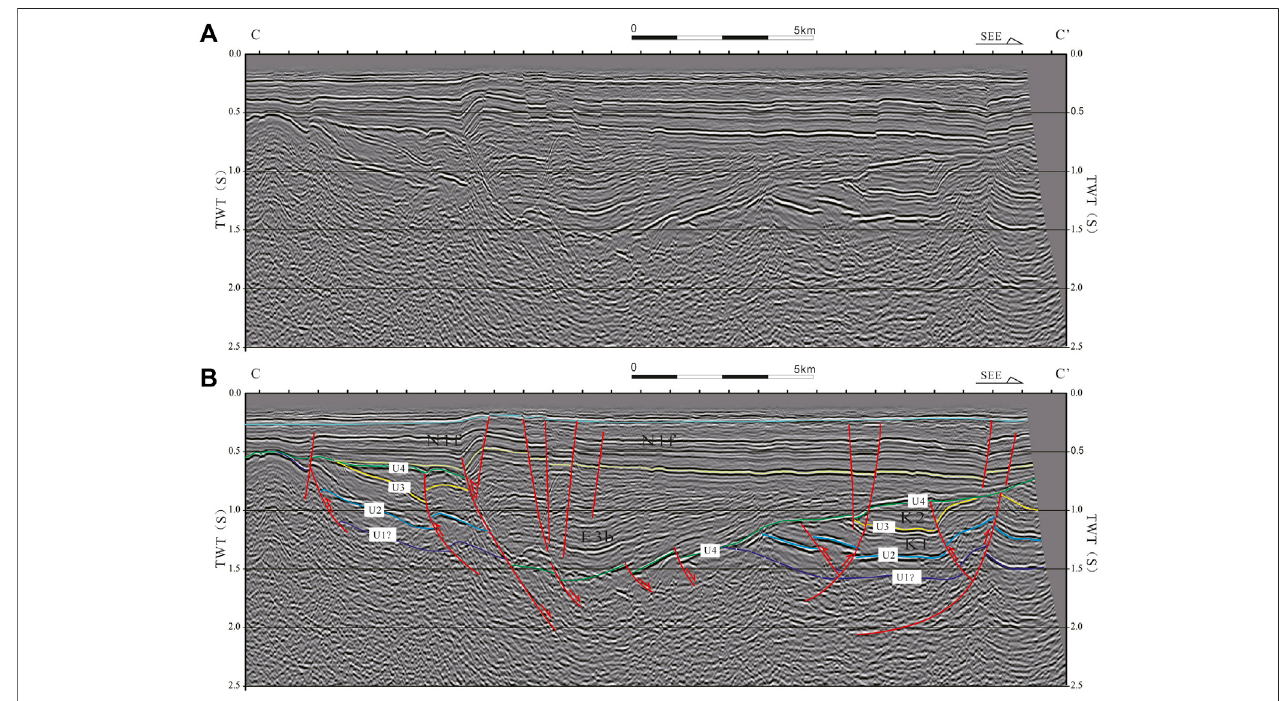
FIGURE 7 | Seismic re fl ection pro fi le C-C ’ (A) and related geological interpretation (B) , showing the characteristics of the U4 unconformity (see Figure 1 for the location). A cluster of Cenozoic faults occurs above the Mesozoic faults. Symbols and abbreviations are the same as those in Figures 2 , 3 .